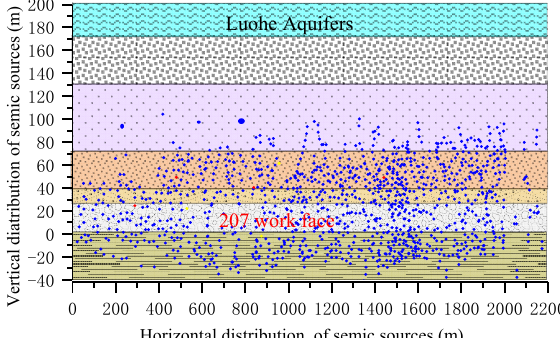
Figure 12. Vertical distribution of micro-seismic events.